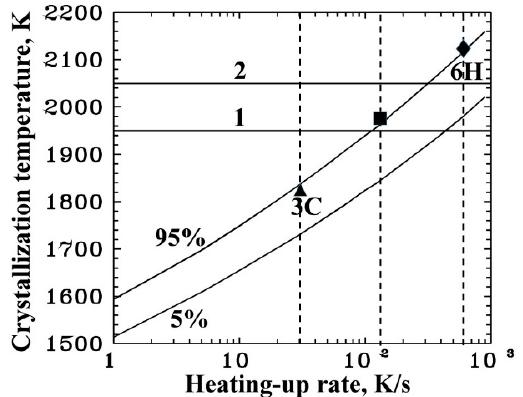
Figure 4. Influence of the linear heating-up rates during high-temperature RTP annealing on the polytypic structure of the recrystallized ion-implanted 6H-SiC: 1 – transition temperature for 1 × 10 15 cm − 2 ; 2 - transition temperature for 5 × 10 15 cm − 2 . Transition temperatures are given according to Figure 1 ( a ) for an Al + ion-implantation. Data points for the experimental conditions of the ramp rate dependent annealing in Figure 3: ▲ – 30 K s −1 (Figure 3 ( a )); ■ – 120 K s −1 (Figure 3 ( b )); ♦ - 600 K s −1 (Figure 3 ( c )).